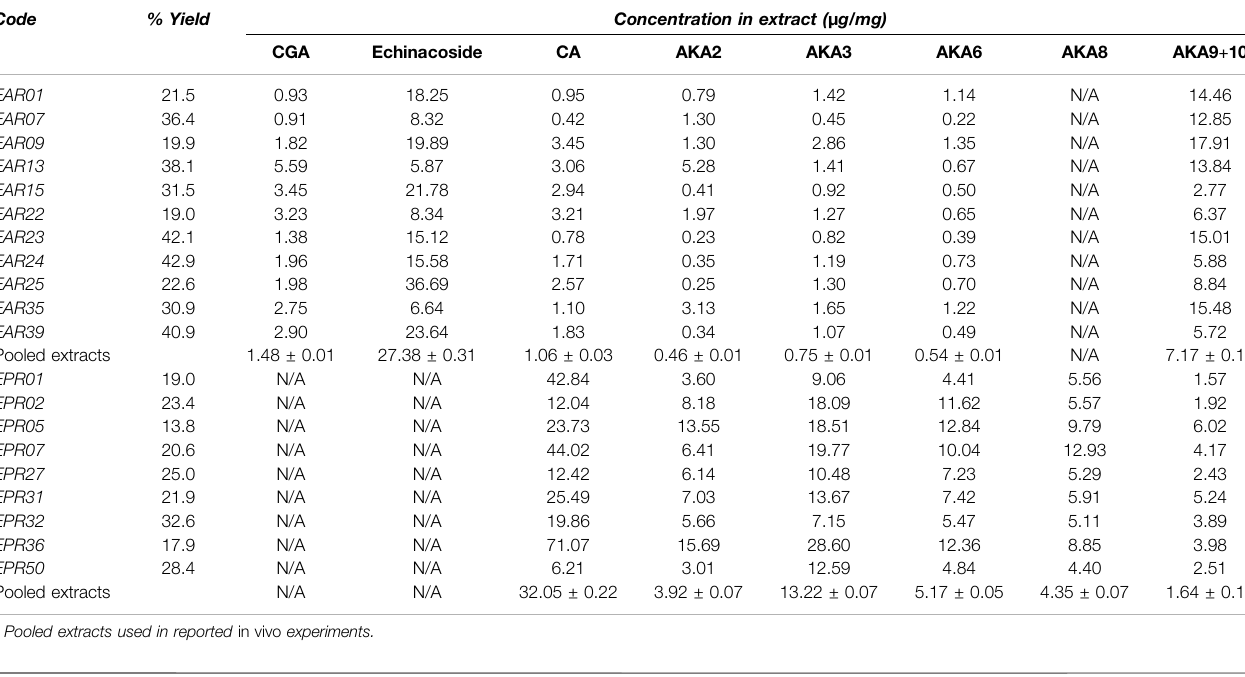
TABLE 1 | HPLC-DAD quanti fi cation of major components in Echinacea spp root extracts. Mean concentration in each genotype (technical replicates, n (cid:1) 3) of caffeic acid derivatives [chlorogenic acid (CGA), echinacoside and cichoric acid (CA)] and alkylamides (AKA) are presented together with mean concentration across coded genotypes ofeach species. Coef fi cients ofvariation fortechnical replicates werebelow8%ofmean values. Pooled extracts used foranimaltrials differed from means due to varying yields among pooled root extracts. Code % Yield